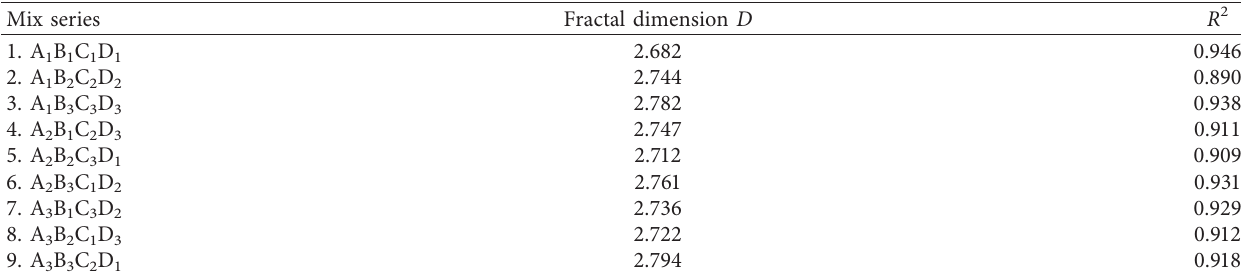
Figure 7: Fractal dimension fitting of apertures of RCASCC with different mixes. (a) A Table 15: Fractal dimension of pore volume of